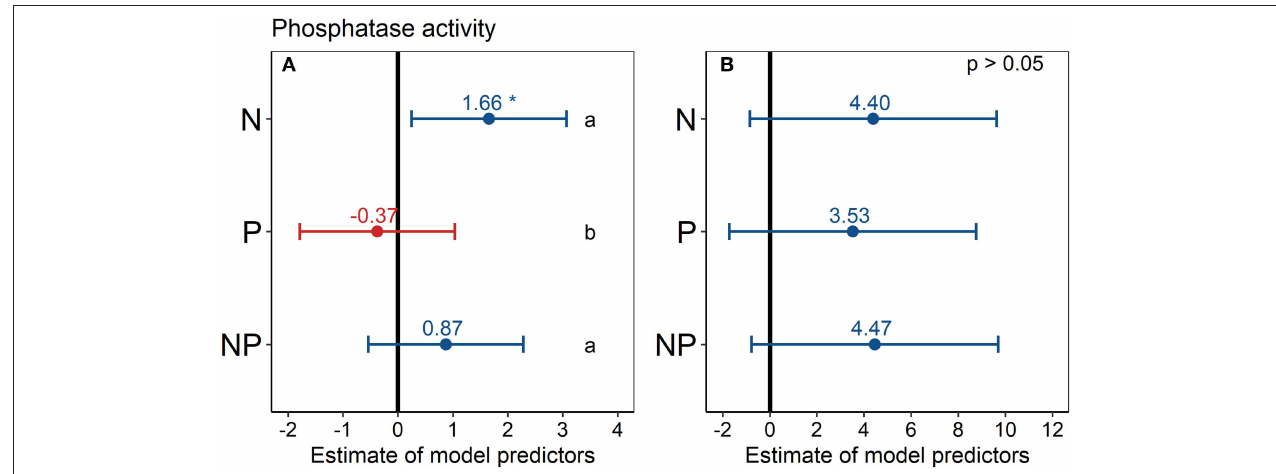
FIGURE 5 | Effect of nutrient addition (N, P, NP) on soil phosphatase activity across all six sites in (A) 0–15cm depth and (B) 15–30cm depth. A linear mixed-effects model was calculated with treatment as fixed factor and random intercepts for sites. Points represent the mean value of the model predictor while error bars represent the range of 95% confidence intervals. Predictors are considered significant, if error bars do not overlap with zero, indicated with asterisks. The vertical intercept (position zero) corresponds to the control. Significant differences between treatments (N, P, and NP) are indicated by lower-case letters at the right side of the